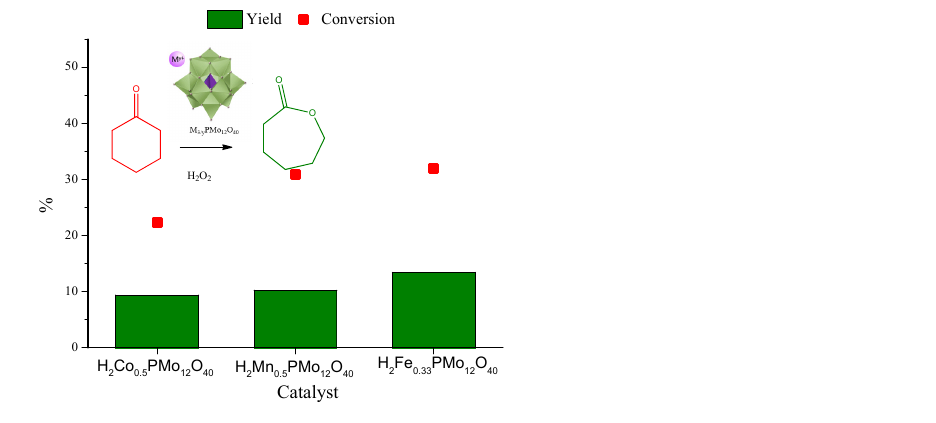
Figure 18. Baeyer Villiger oxidation of cyclohexanone with hydrogen peroxide over partially exchanged-phosphomolybdic acid salts (adapted from ref. [12]).